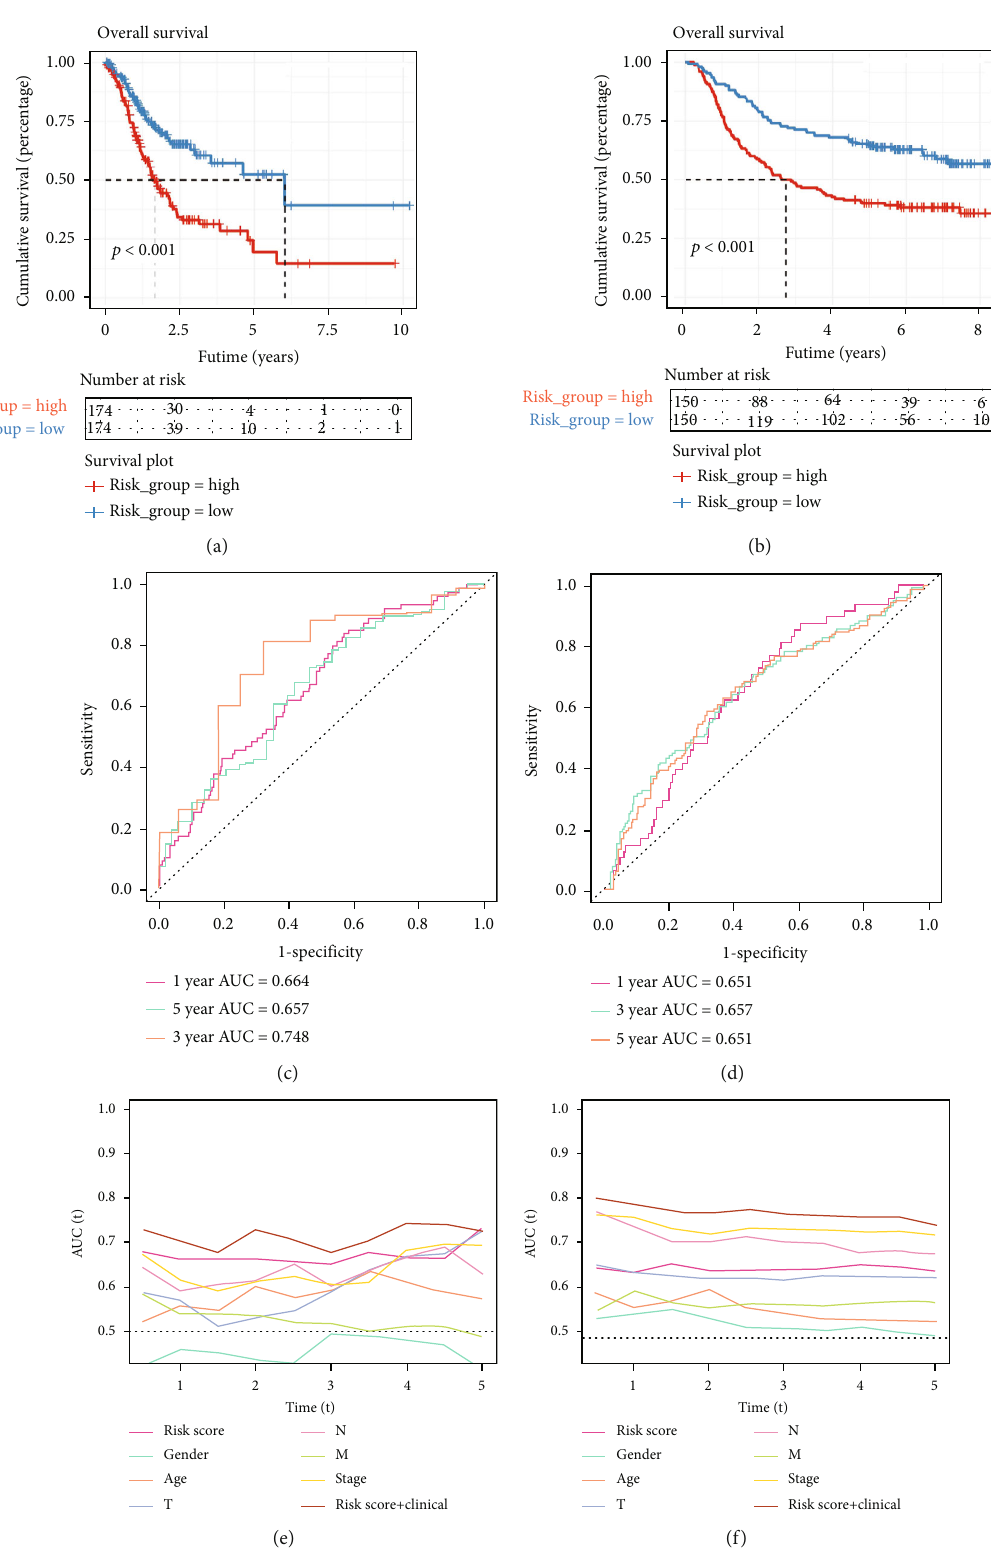
Figure 4: Evaluation of the model. (a, c, e) In TCGA dataset, the relationship between the model and the prognostic overall survival, the accuracy and stability of the model in predicting the prognosis of gastric cancer patients, and the comparison of the risk value and clinical characteristics of the model and the combination of the two indicators for prognosis evaluation. Similarly, (b, d, f) are the results in the GSE62254